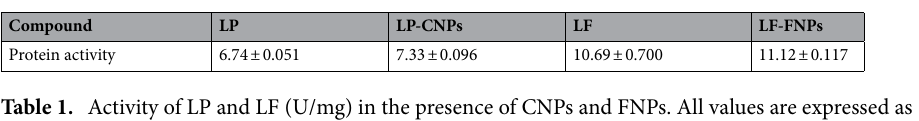
Table 1. Activity of LP and LF (U/mg) in the presence of CNPs and FNPs. All values are expressed as mean ± S.E. CNPs: CuO nanoparticles; FNPs: iron nanoparticles; LF: lactoferrin; LP: